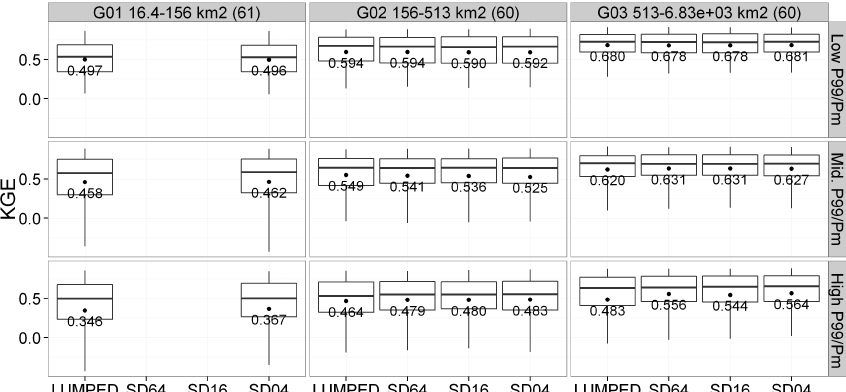
Fig. 10. Distributions of model performance in validation mode for three catchment groups sorted by increasing catchment area (G01, G02, and G03, left to right panels) and by increasing rainfall intensity coefficient (low, intermediate and high P 99 /P m ; top to bottom panels). The model performance was computed for 3620 flood events and for different spatial resolutions of precipitation forcing (LUMPED, SD64, SD16 and SD04). The box plots show the 5th, 25th, 50th, 75th, and 95th percentiles, and the mean value is shown by a